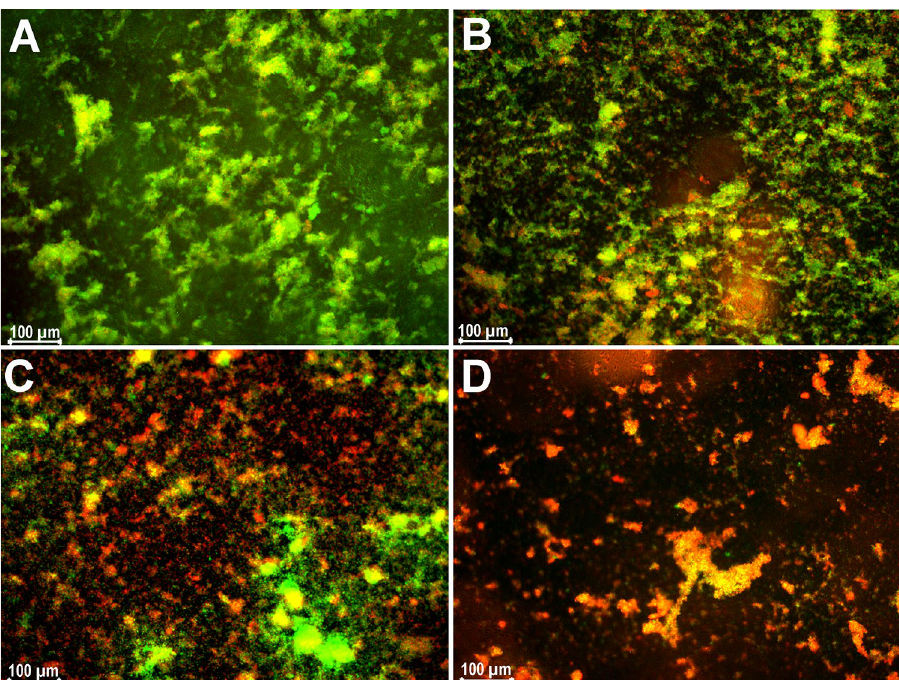
Figure 2. Live/dead stained images of S. aureus biofilm treated with ( A ) no antibiotic (control), ( B ) 4 mg/l of dalbavancin, ( C ) 8 mg/l of dalbavancin, ( D ) 32 mg/l of dalbavancin, visualized by fluorescence microscopy. Vital cells stain green (fluorescein positive and PI negative), dead cells stain red (fluorescein negative and PI positive). One representative picture is shown for each